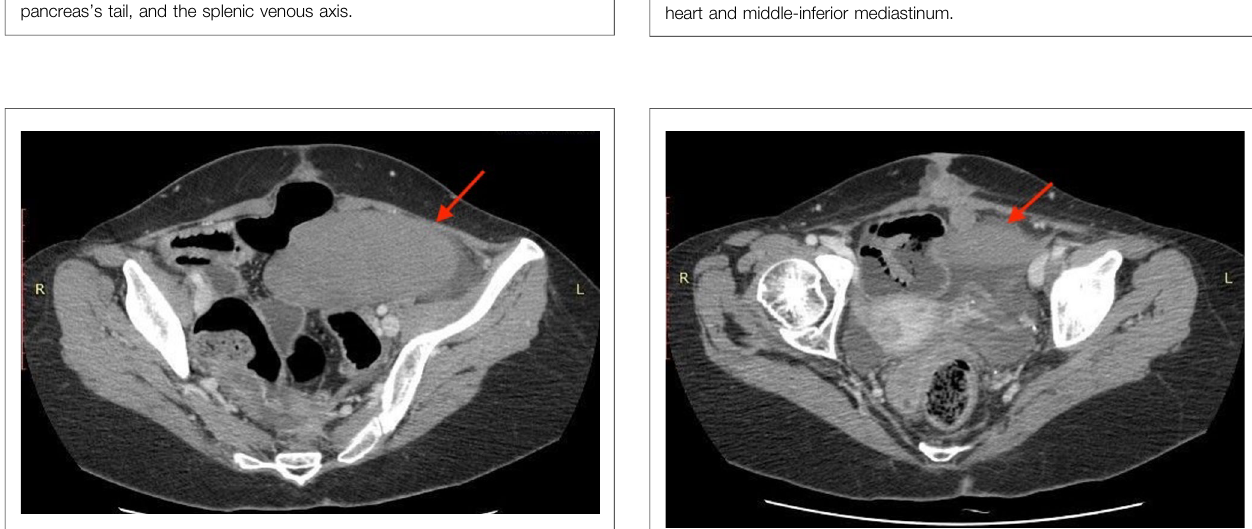
FIGURE 1 | “ Whirl ” radiological sign of volvulus, involving mesenteric fat, pancreas ’ s tail, and the splenic venous axis.